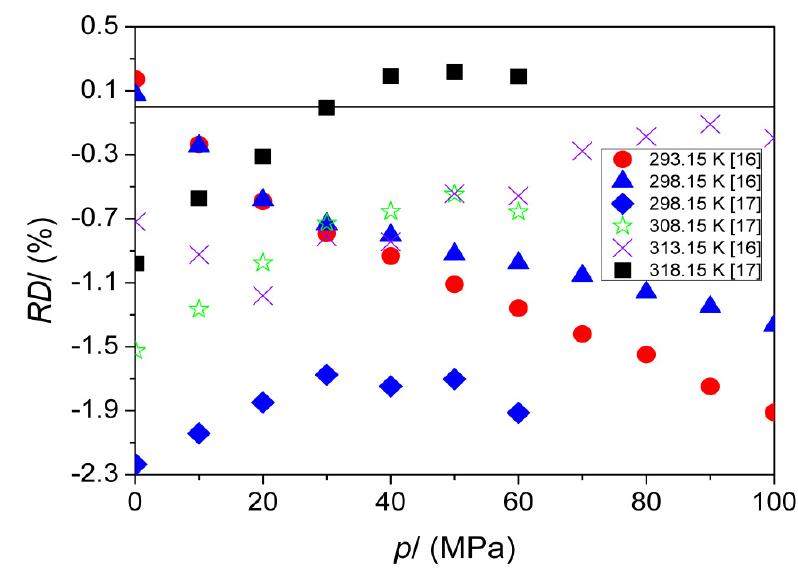
Figure 7. Comparison of the isobaric thermal expansion of 1-butanol as a function of pressure obtained in this work ( α p , this work ) with the literature values ( α p , lit ) [16,17] presented as relative deviations RD s ( RD / % = 100 · ( α p , this work − α p , lit ) / α p , this work ).